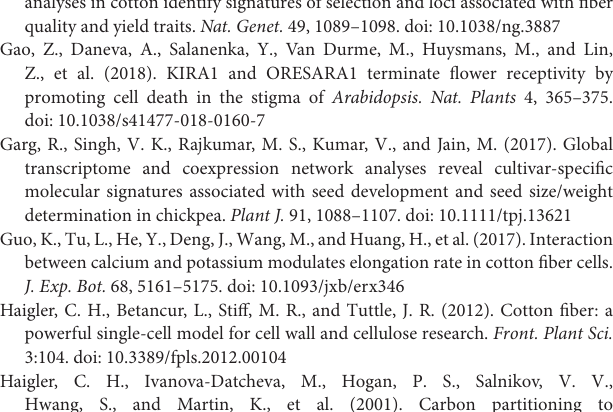
Supplementary Figure 2 | Comparison of fiber quality and boll weight over multiple years. (A) Fiber strength, (B) micronaire, and (C) boll weight of LMY22 and SL15 based on a four-year field trial from 2016 to 2019 (mean ± s.d., n = 5, ∗ P < 0.05). Supplementary Figure 3 | Comparison of seed index and seed number of per boll as well as fuzz content. (A) Seed index of LMY22 and SL15 in 2018 and 2019 (mean ± s.d., n = 50). (B) Number of seeds per boll (mean ± s.d., n = 20). (C) Fuzz content of LMY22 and SL15 (mean ± s.d., n = 50). Supplementary Figure 4 | The number of mature fibers per unit weight. (A) Fiber number of per unit length (N1), mean ± s.d., n = 50, ∗∗ P < 0.01. (B) Mean fiber length (mm) was determined by AFIS (mean ± s.d., n = 5). (C) Number of mature fibers (N2) in 2mg was calculated from the following equation: (N2) = (N1 × 10)/(the mean fiber length of LMY22 and SL15, respectively), mean ± s.d., n = 50, ∗∗ P < 0.01.